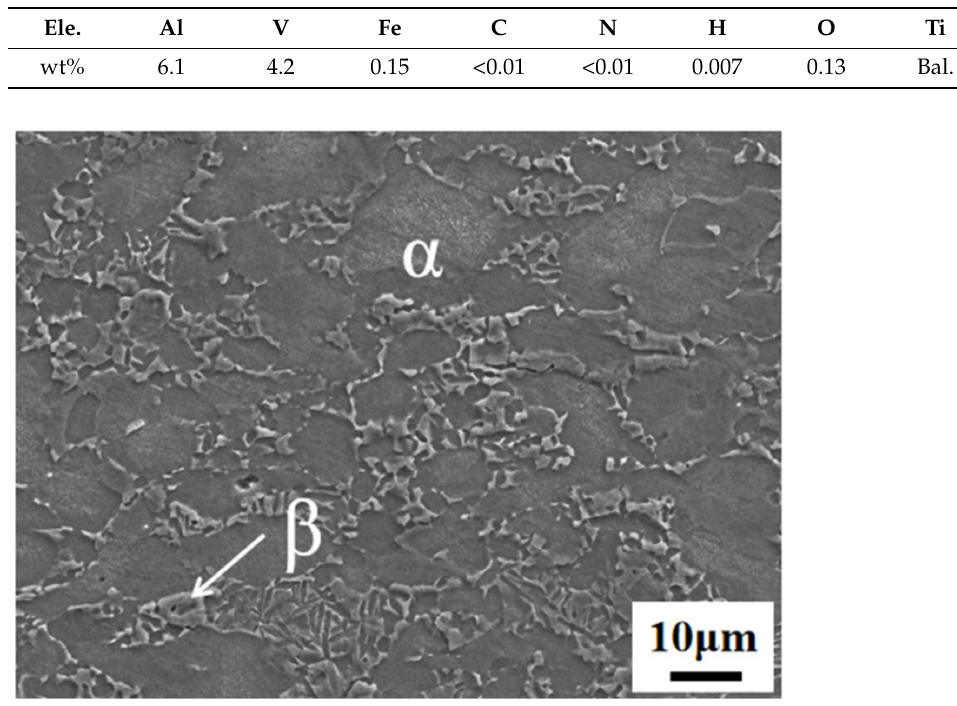
Table 1. Chemical composition of the as-received TC4 in weight percentage.